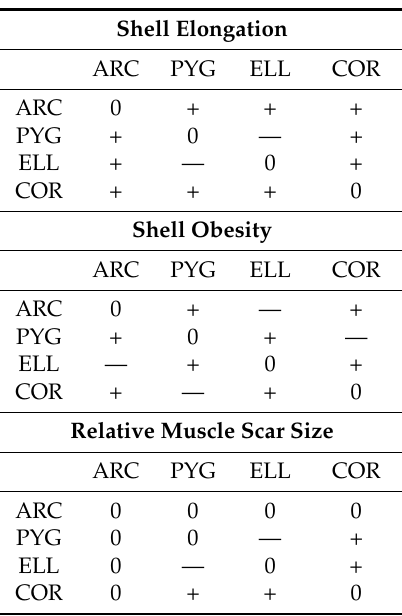
Table 3. Results of t-tests for shell shape and muscle size parameters. 0 means no test; + means significantly different (p ≤ 0.001); — means not significantly different (p > 0.001). ARC—